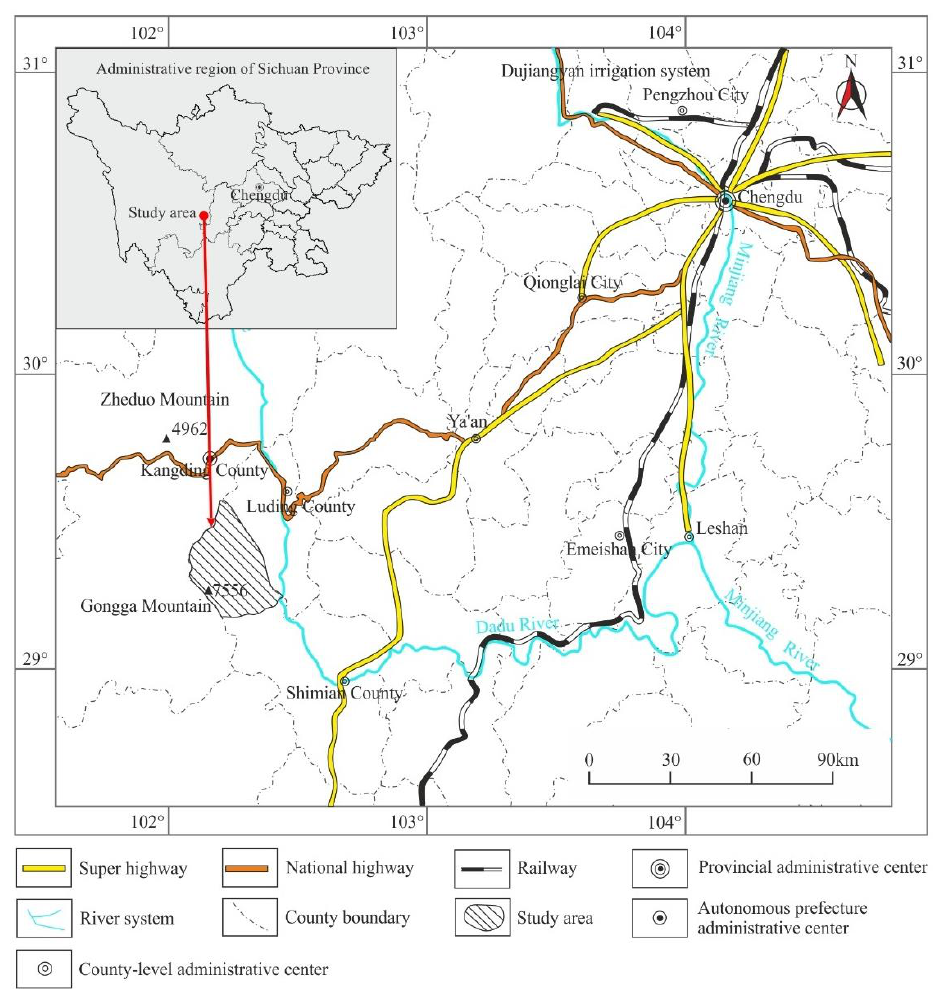
Figure 1. Traffic location map of the study area.